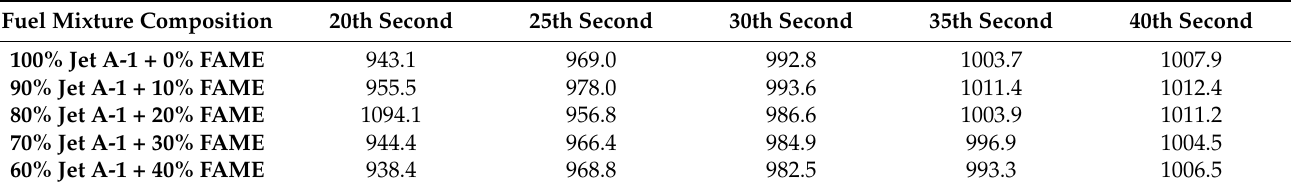
Table 14. Change in total gas temperature in front of the gas turbine t 3t [°C] SJE-20 with different concentrations of Jet A-1 aviation kerosene and FAME biofuel.